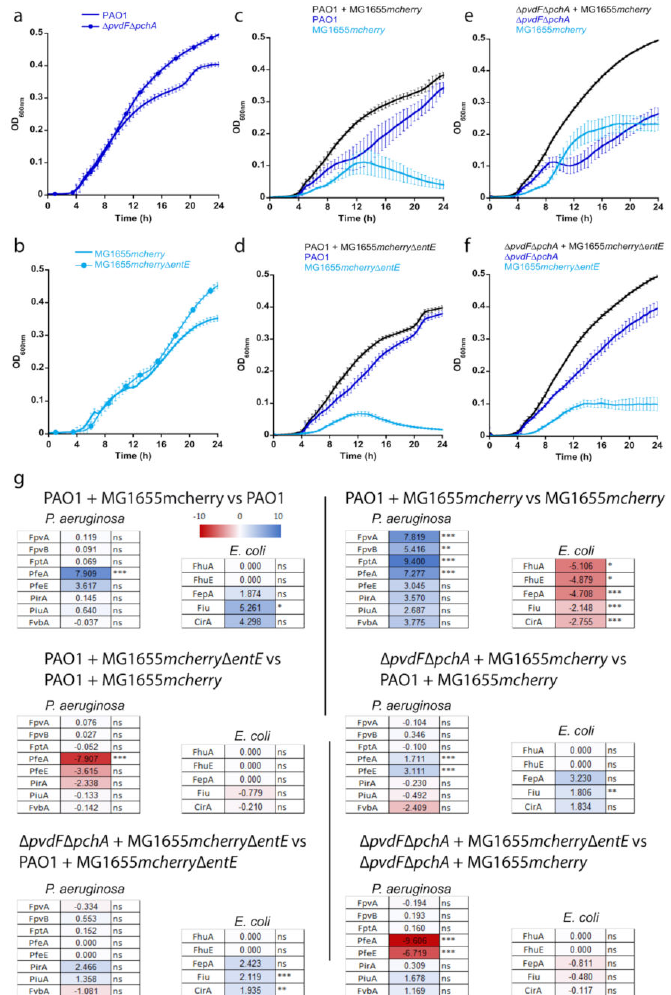
Figure 4. Co-cultures between P. aeruginosa and E. coli . All cultures were carried out in CAA medium supplemented with 0.6% glycerol at 30 ◦ C. ( a ) Growth of P. aeruginosa strains producing, or not, PVD and PCH (PAO1 and ∆ pvdF ∆ pchA ). Both strains were grown alone. ( b ) Growth of E. coli producing, or not, ENT (MG1655 mcherry or MG1655 mcherry ∆ entE ). Both strains were grown alone. ( c – f ) Co-cultures between P. aeruginosa strains producing, or not, PVD and PCH (PAO1 and ∆ pvdF ∆ pchA , respectively) with E. coli producing, or not, ENT ((MG1655 mcherry or MG1655 mcherry ∆ entE , respectively). For the co-cultures, both strains were mixed at an OD of 0.005 and the bacterial growth followed by monitoring the OD at 600 nm. MG1655 mcherry and MG1655 mcherry ∆ entE both carry a plasmid encoding mCherry and the fluorescence of this protein was followed at 610 nm (excitation: 570 nm) (Figure S1 in Supplementary Materials). These values at 610 nm were used to identify the portion of the OD signal at 600 nm in the co-cultures due to E. coli and that due to P. aeruginosa . All data (panels ( a – f )) are the means of three independent experiments. Figure S1 also shows the production of PVD by PAO1 in the various co-cultures. ( g ). Differential proteomic analyses were performed in parallel on the P. aeruginosa and E. coli proteomes for the cultures and co-cultures presented in panels ( a – f ). Volcano plots are shown in Figure S2 for P. aeruginosa and in Figure S3 for E. coli . Panel ( g ) shows the heat maps of these differential proteomic analyses for some TBDTs involved in iron-uptake in P. aeruginosa and in E. coli . For P. aeruginosa , FpvA and FpvB are the outer membrane transporters of ferri-PVD [30,38], FptA of ferri-PCH [31], PfeA and PirA of ferri-ENT [21,23], PiuA [39] and FvbA [40] of ferri-catechol-type siderophores, and, finally, PfeE is the esterase of the ENT pathway [25]. For E. coli , FepA is the outer membrane transporter of ferri-ENT, Fiu and CirA of other ferri-catechol- siderophores, and FhuA and FhuE of hydroxamate siderophores [41]. The darker the shade of blue, the higher the expression of the protein, and the darker the shade of red, the more the expression of the protein is repressed * p < 0.05, ** p < 0.01, *** p <